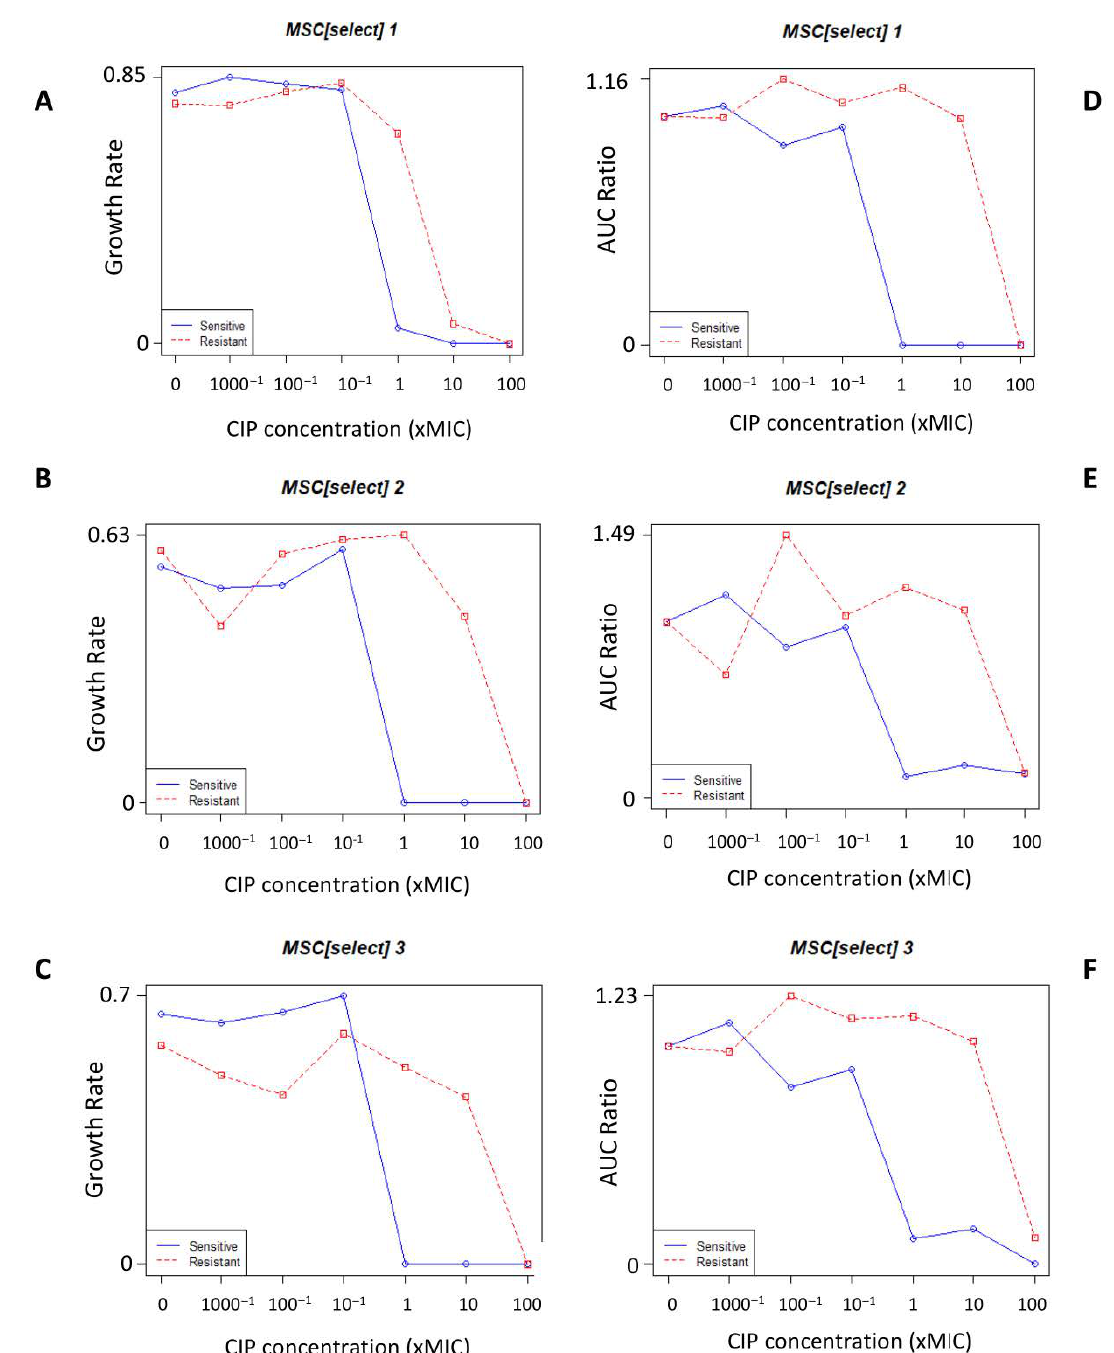
Figure 2. Growth rates as a function of ciprofloxacin (CIP) concentrations. The relative exponential growth rates ( A – C ) and AUC ratio ( D – F ) of N. gonorrhoeae WHO-P with (red) and without (blue) the gyrA S91F mutation conferring resistance to ciprofloxacin. The MSC select is determined as the point where the blue and red lines intersect.